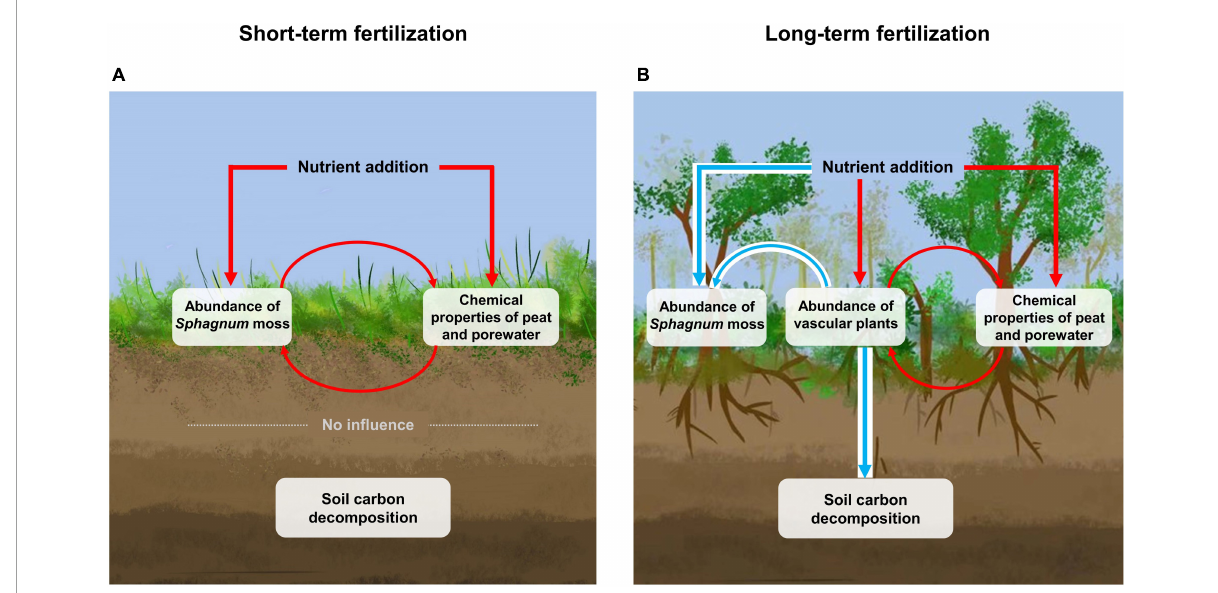
FIGURE4 Schematic diagrams of the mechanisms of soil C protection in the short- (A) and long-term fertilizations (B) . Red arrows indicate positive influences and blue arrows indicate negative